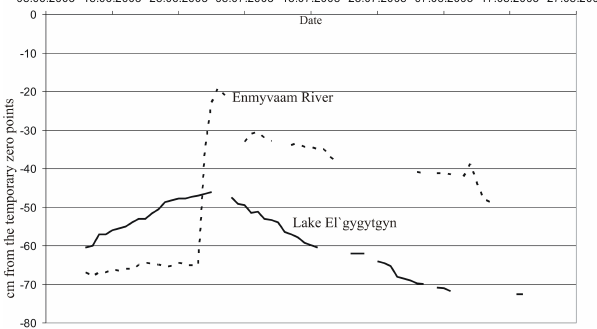
Fig. 3. Water level changes in Lake El’gygytgyn (solid line) and Enmyvaam River (dashed line) during summer 2003. Lake and river level measurements had two different temporary zero